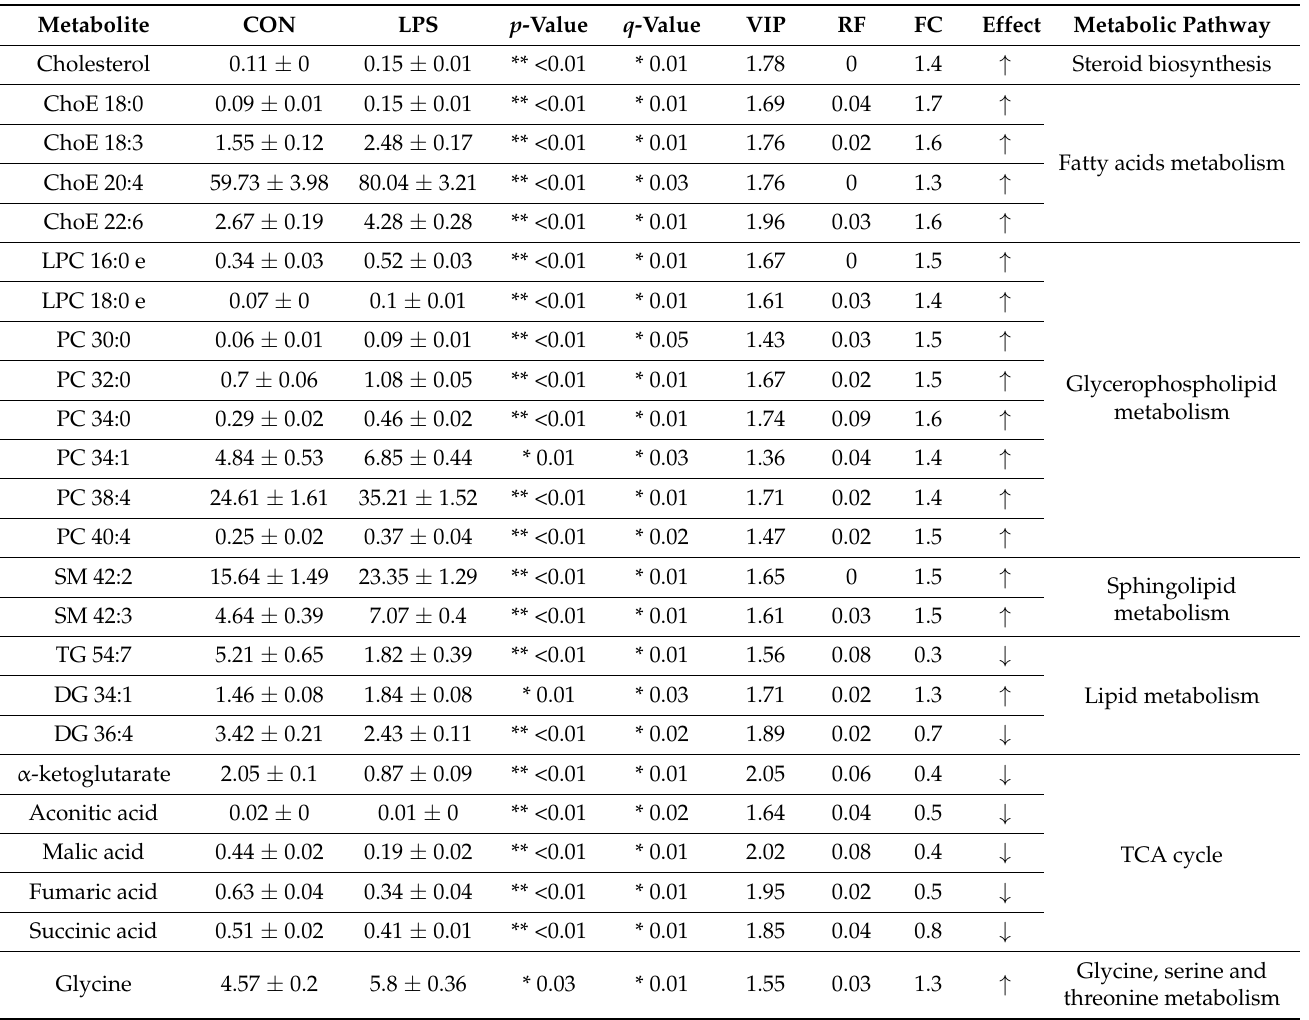
Table 2. Summary of the significant differential plasma metabolites in the LPS-induced inflammation model. CON and LPS groups ( n = 10 animals per group) are represented by the relative abundances (AU). Relative abundances of metabolites are presented by the mean ± SEM. Plasma metabolites are sorted by p -value. The summary of the analysis is shown and includes the relative abundances of metabolites, p -value, q -value, VIP value, fold change (FC), the effect of the LPS vs. the CON group, and the related metabolic pathway. * p < 0.05 (significantly different) and ** p < 0.01 (highly significant difference) compared with control. Abbreviations: ChoE, cholesterol ester; LPC,